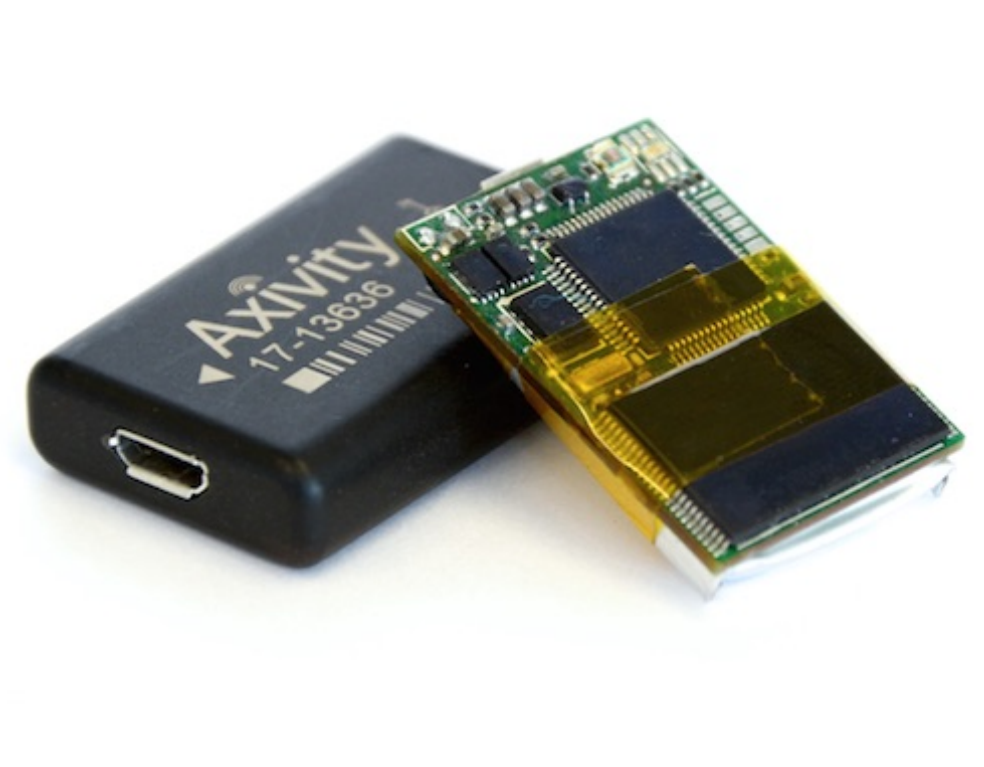
Figure 5. The Axivity AX3 accelerometer as the measurement